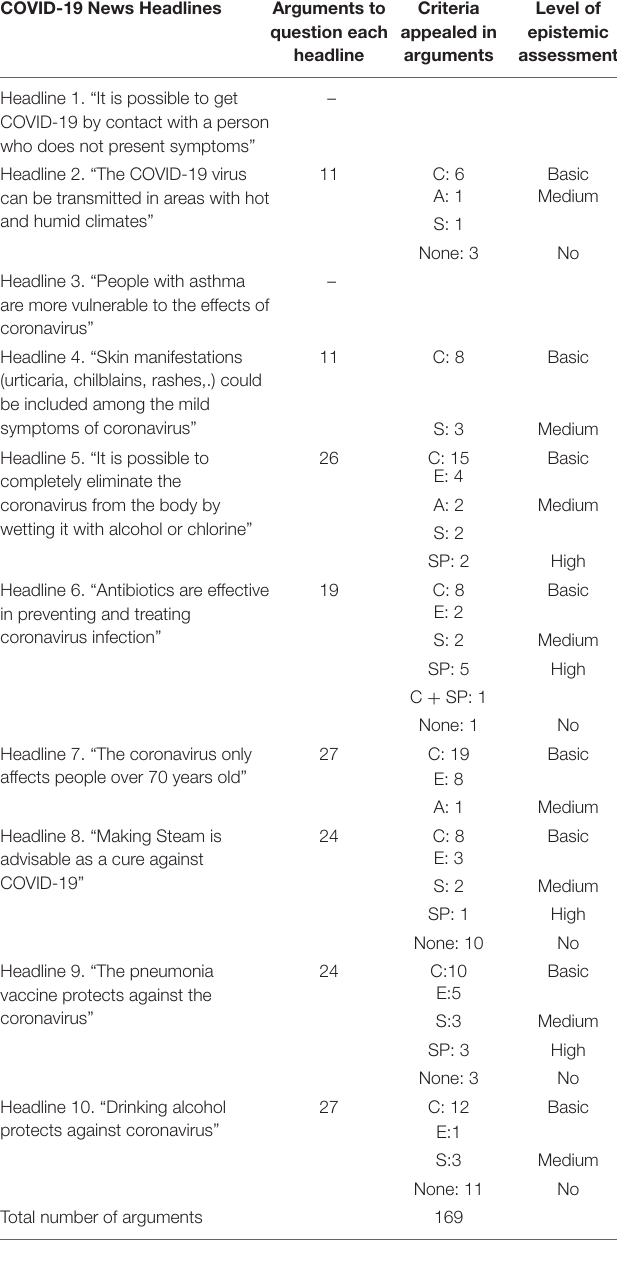
TABLE 4 | Arguments used by students to assess the credibility of each COVID-19 headline. COVID-19 News Headlines Arguments to